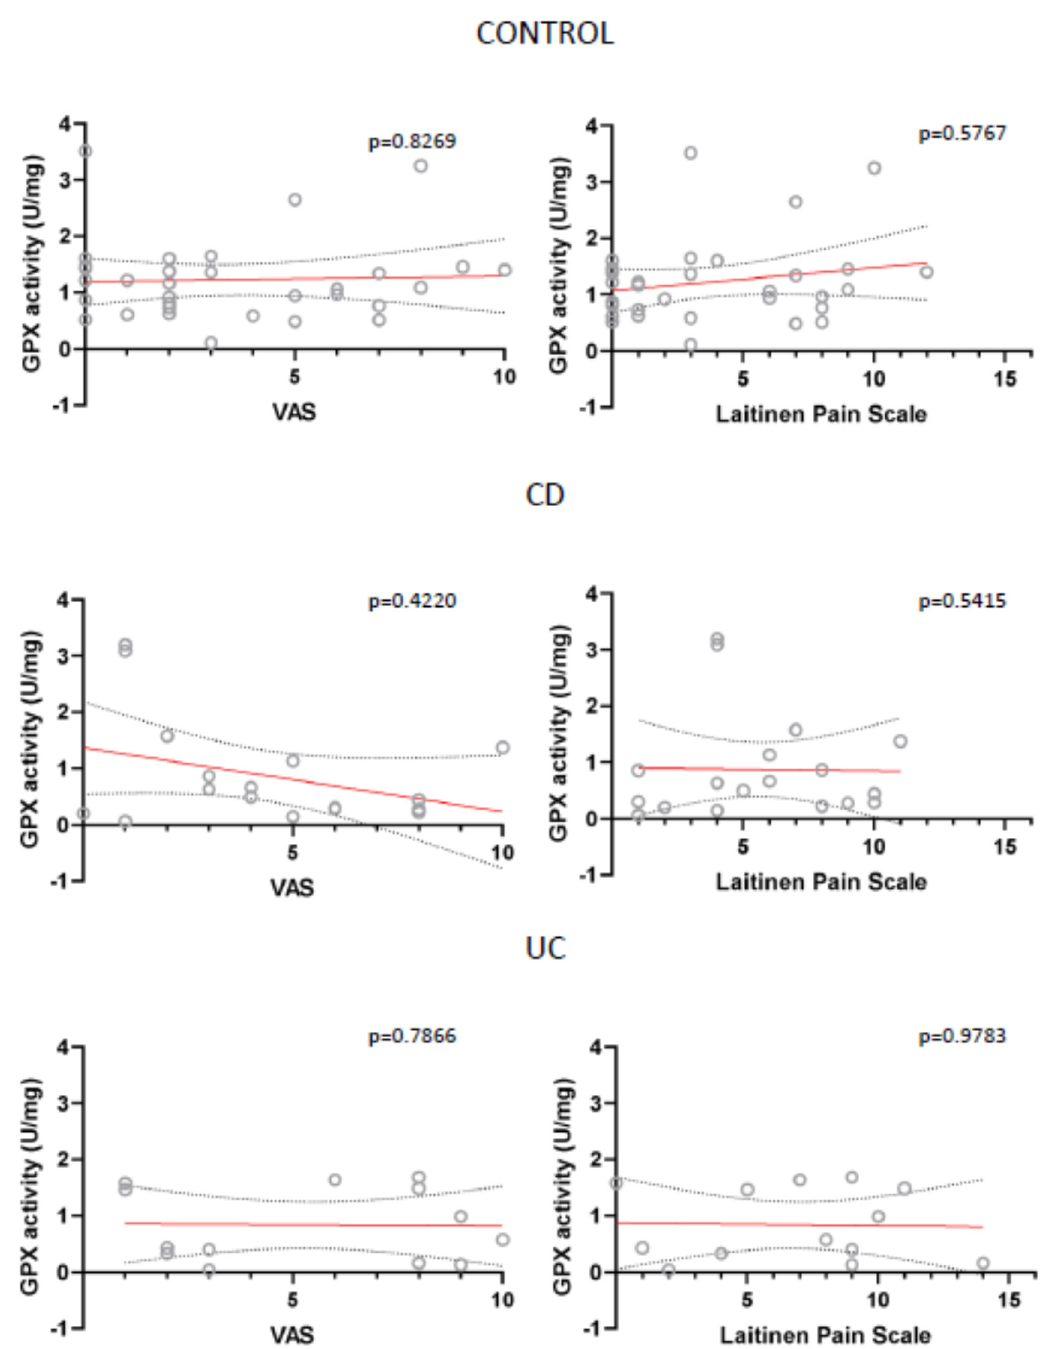
Figure 10. Correlation between the mean values of visual analog scale (VAS) for quantification of disease-related pain, the values of modified Laitinen Pain Scale and GPX activity (U/mg sample) in controls, CD and UC patients.